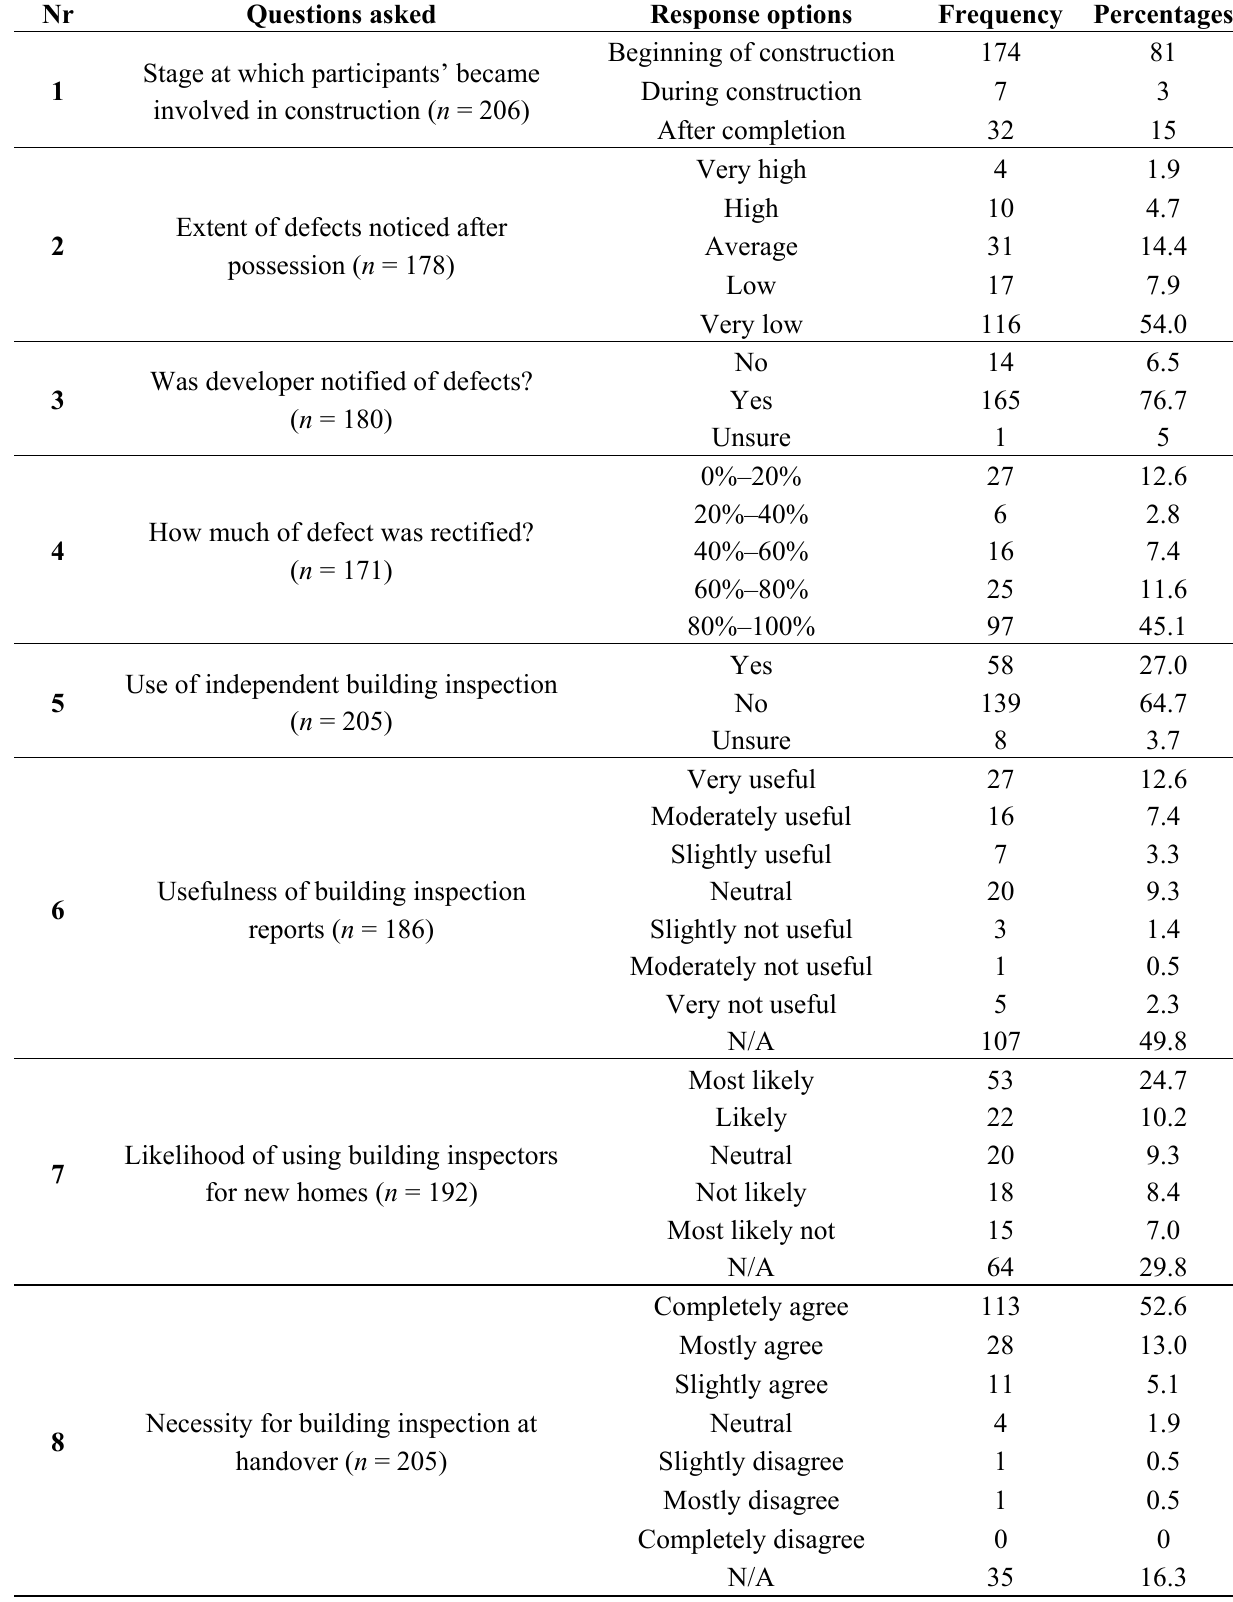
Table 2. Summary of responses to survey